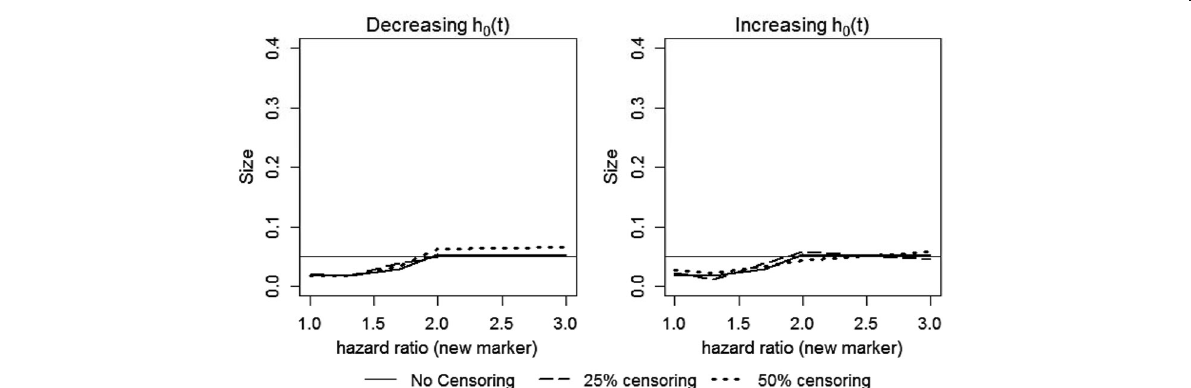
Fig. 2 Size of the RC Greenwood-Nam-D ’ Agostino test (RC-GND) (2) for 0, 25, and 50% censoring rates. Comparing full ( y ~ x 1 + x 2 ) and reduced ( y ~ x 1 ) models with decreasing (left) and increasing (right) baseline hazard functions. N = 5000, p = 0.1, collapse when ev g <